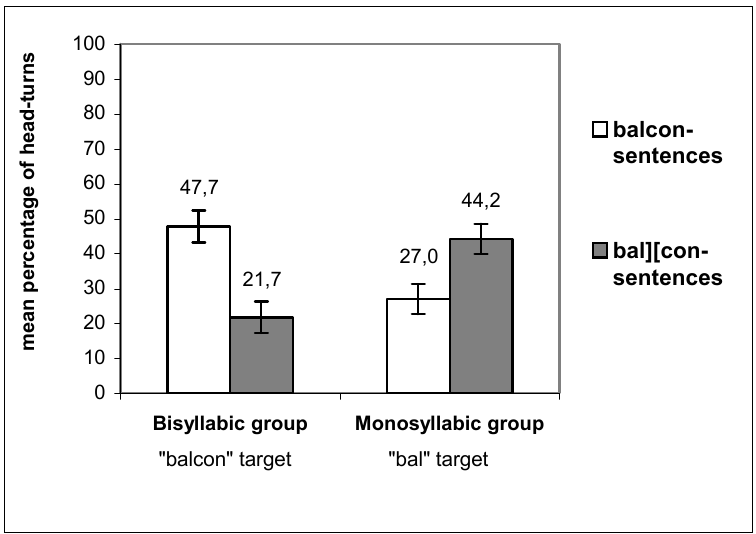
Figure 2: Mean percentage of head-turns for 16-month-old French infants in the bisyllabic group (on the left) and in the monosyllabic group (on the right). Infants heard sentences containing the bisyllabic word (balcon-sentences, white bars) and sentences containing its two syllables separated by a phonological phrase boundary (bal][con-sentences, grey